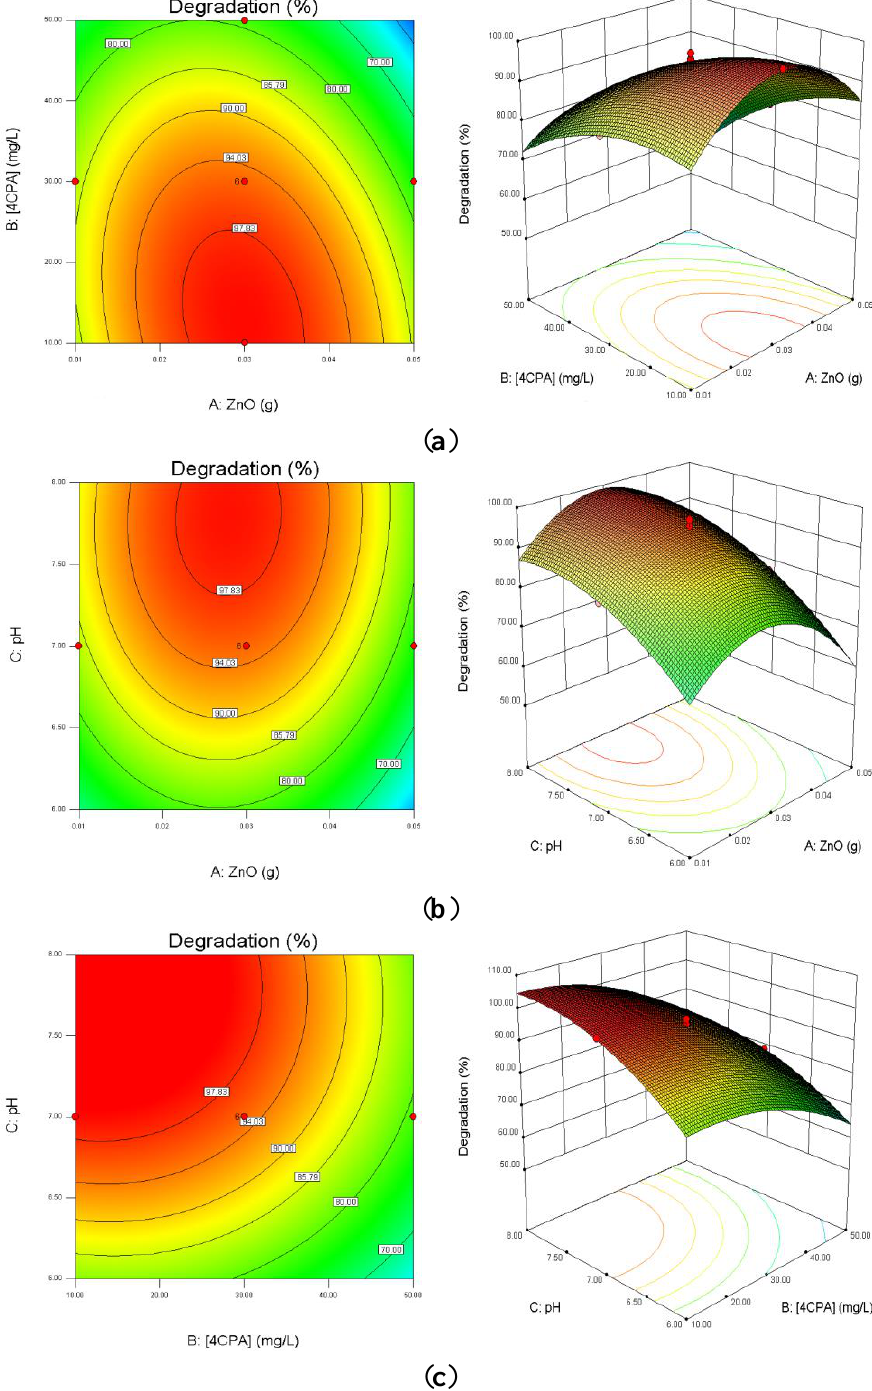
Figure 6. Effects of ZnO loading, initial concentration of 4-CPA and pH on the degradation percentage of 4-CPA. ( a ) pH was kept constant at 7.0; ( b ) 4-CPA initial concentration was kept constant at 30 mg/L; ( c ) ZnO loading was kept constant at 0.03